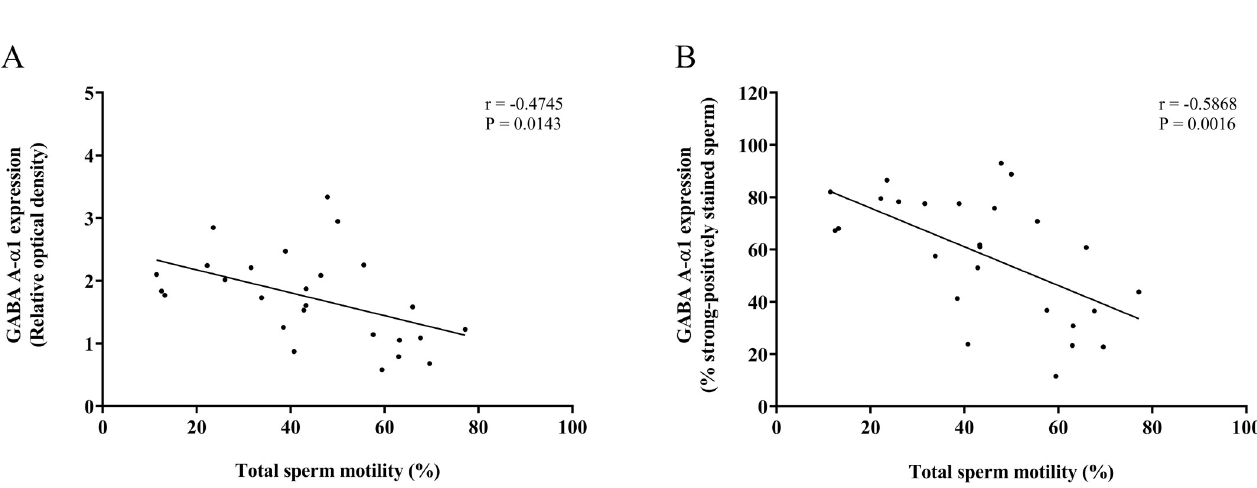
Fig 11. Correlations between the percentage of total sperm motility and GABA A- α 1 receptor expression in sperm. (A) Relative optical density. (B) The percentage of strong-positively stained sperm for GABA A- α 1 receptor immunostaining. Linear regression line (black line) fitted to all data points.